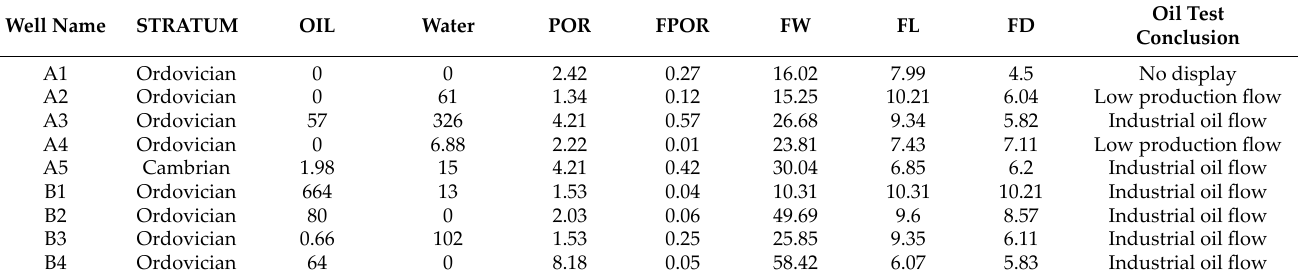
Table 3. Average values of fracture porosity and fracture parameters in the target layer.